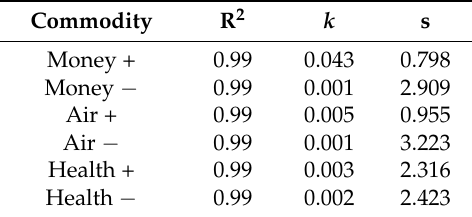
Table 2. R 2 , k , and s values for gains and losses of monetary, air, and health